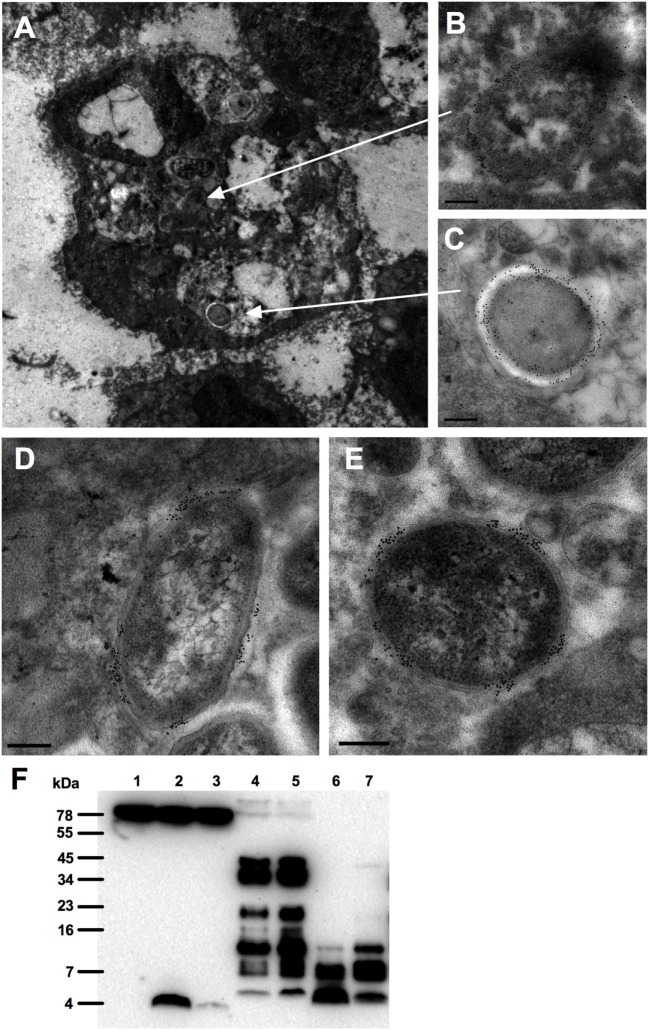
Interactions of thrombin-derived C-terminal peptides with bacteria in wounds. Thrombin-derived C-terminal peptides are visualized in fibrin slough by gold labeling (indicated as black dots) using electron microscopy. (A) Overview of a polymorphonuclear leukocyte in fibrin slough from a patient with a non-healing venous ulcer colonized with Pseudomonas aeruginosa and Staphylococcus aureus, showing the binding of thrombin-derived C-terminal peptide (TCP) epitopes to a phagocytosed bacillus (B) and a coccus (C). In addition, TCPs are bound to a bacillus (D) and a coccus (E) that are present extracellularly in the fibrin slough. Scale bar, 0.2 µm. (F) Western blot analysis detected the presence of TCPs in acute (lanes 4–5) and chronic (lanes 6–7) wound fluids. Human plasma is shown in lane 1, human plasma with GKY25 in lane 2 or with HVF18 in lane 3.